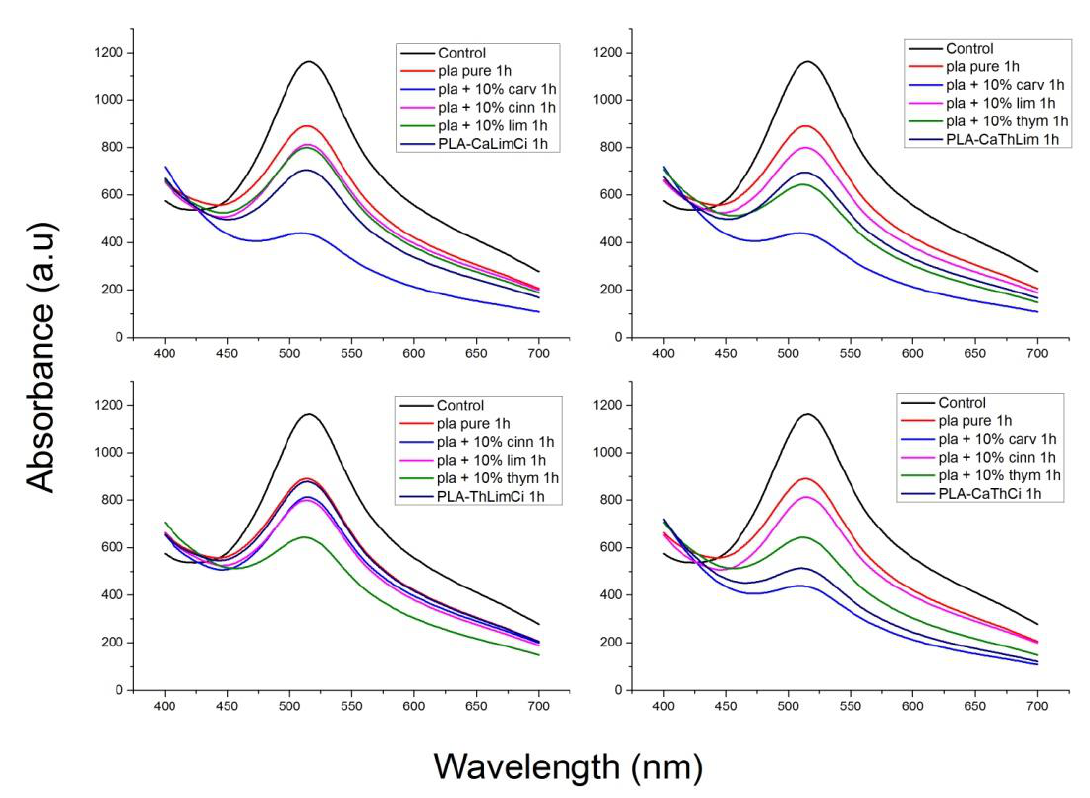
Figure 15. Comparative UV spectra of neat PLA, each ternary composite and the components of this composite after 1 h in DPPH solution.